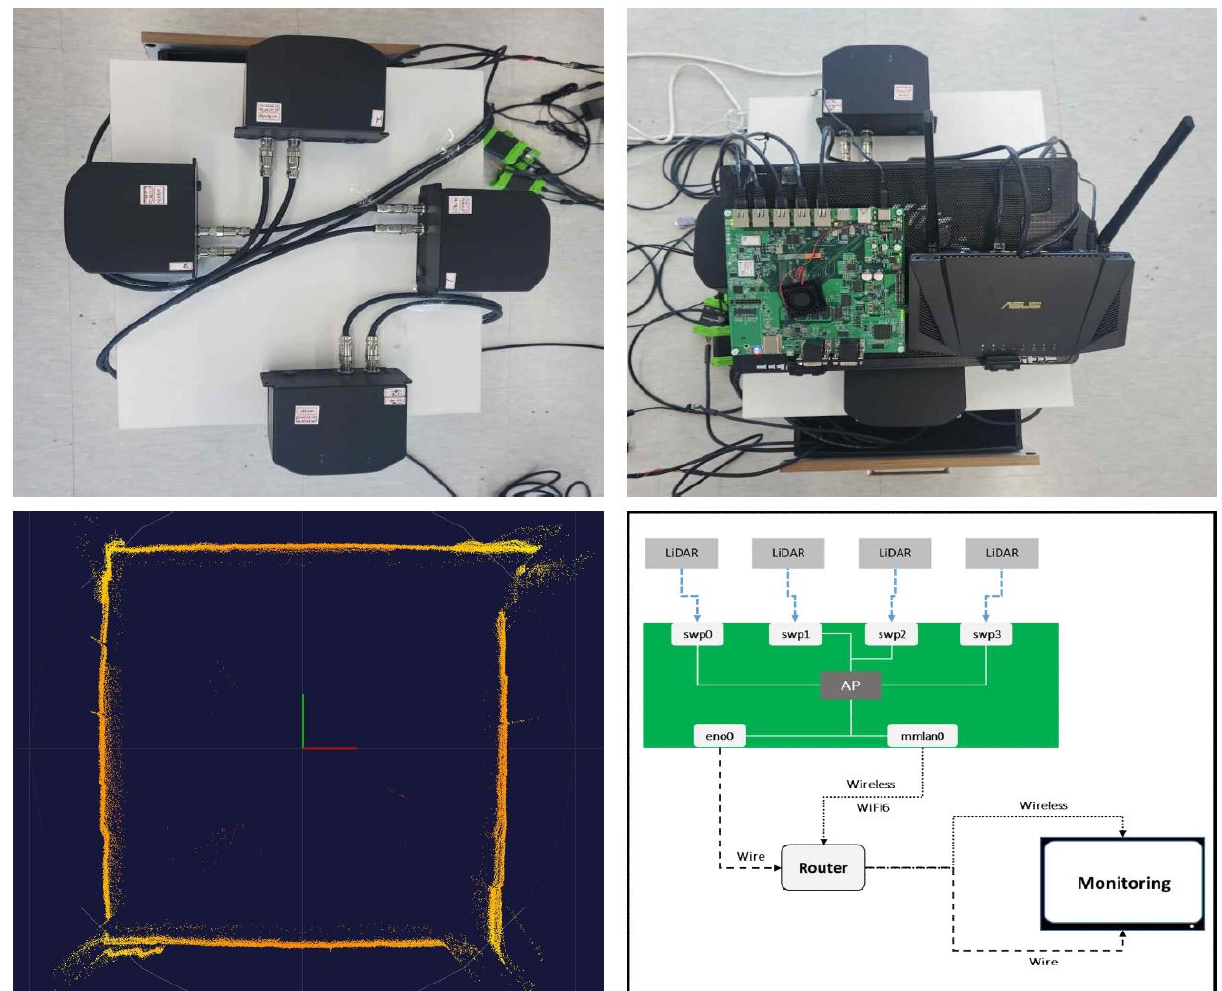
Figure 7. Experimental environment using multiple LiDARs.